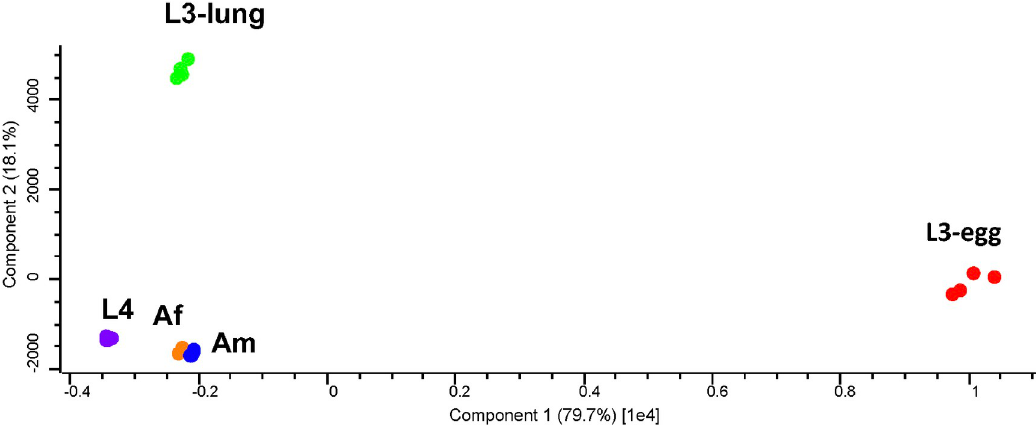
Fig 3. Principal component analysis of the developmental lipidome of Ascaris suum representing infective third-stage (L3-egg), lung stage L3 (L3-lung) and fourth-stage (L4) larvae; female (Af) and male adults (Am).